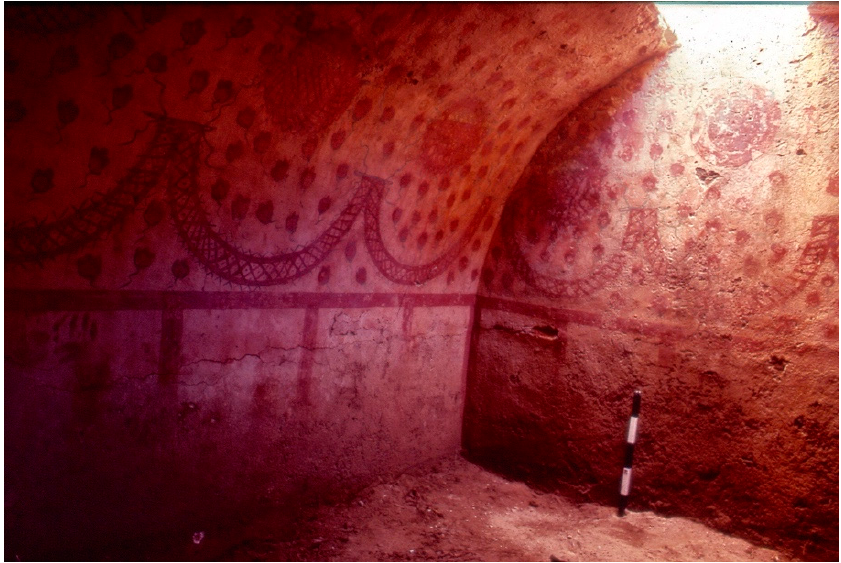
Figure 24. Sardis, Tomb 79.1 (Appendix A.8), southwest corner. © Archaeological Exploration of Sardis/President and fellows of Harvard College.